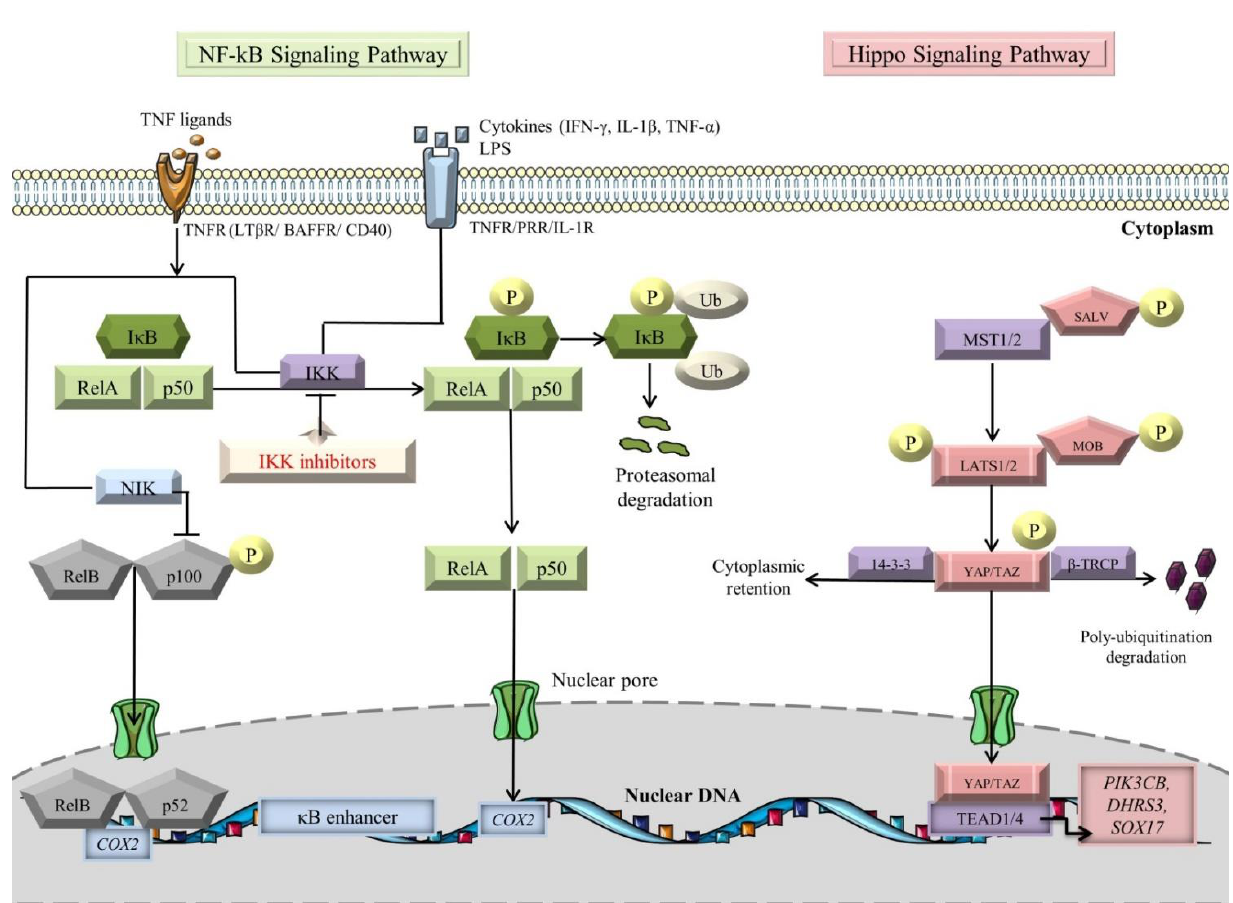
Figure 1. NF-kB and Hippo signaling pathways (see main text for details). The black arrows designate central signaling pathways; the continuous lines denote induction; and the continuous blunt-ended lines signify inhibition. BAFFR: B-cell-activating factor receptor; COX2: cyclooxygenase 2; DHRS3: dehydrogenase/reductase 3; IFN- γ : Interferon γ ; IkB: inhibitor of NF-kB; IKK: I κ B kinase; LATS1/2: large tumor suppressor 1/2; LPS: lipopolysaccharide; LT β R: lymphotoxin β receptor; MOB: LATS1/2- interacting protein Mps one binder; MST1/2: mammalian Sterile 20-like kinases 1/2; NF-kB: Nuclear factor kappa-light-chain-enhancer of activated B cells; NIK: NF- κ B-inducing kinase; P: phosphoryla- tion; PIK3CB: phosphatidylinositol-4,5-bisphosphate 3-kinase catalytic subunit beta; SALV: Salvador; SOX17: SRY-box transcription factor 17; TAZ: transcriptional co-activator with PDZ-binding motif; TEAD1/4: transcription factors with TEA domain; TNF- α : tumor necrosis factor α ; TNFR: TNF re- ceptor; Ub: ubiquitination; YAP: Yes-associated protein; and β -TRCP: β -transducin repeat-containing E3 ubiquitin–protein ligase complex. Segments of the figure were portrayed by using artwork